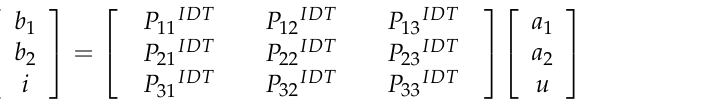
. Figure 7. The P matrix model of an IDT. Differing from IDT, the P matrices of the free waveguide layer and waveguide layer with micro piezoelectric PnCs transmitting paths can be reduced to two acoustical ports, as shown in the following equation: 1 (6) Based on the P matrices of IDT and transmitting paths, the equivalent models of the two SAW delay lines can be derived as shown in Figure 8. We assume that the arrange- ment of delay line structures is perfectly symmetric and the emitting IDT and the receiv- ing IDT are the same. Thus, the P matrices of these IDTs are the same.